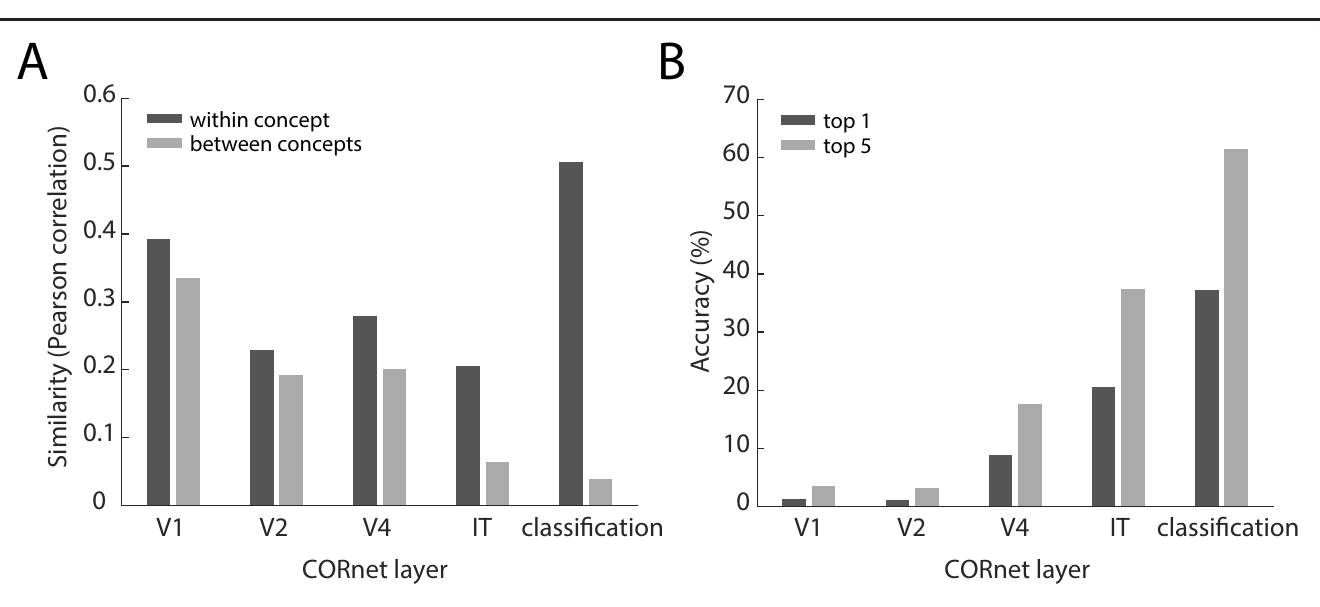
Fig 4. Selectivity of object images for different concepts. (A) Similarity of image activation vectors across different layers of the deep convolutional neural network CORnet [39]. The first four layers of CORnet are named after brain regions in the macaque monkey. Similarity was estimated by the mean Pearson correlation of activation patterns in a given layer. “Within concept” refers to the similarity of all pairs of activation vectors of images of the same concept, while similarity “between concept” refers to the similarity of those images and all other images in the database. Higher selectivity is indicated by a larger difference in “within concept” and “between concept” similarities. (B) Predictive accuracy of activation vectors based on their pairwise Pearson similarity. “Top-1 accuracy” refers to the percentage of the most similar images that belong to the same concept as a reference image and is averaged across all accuracies for all images. “Top-5 accuracy” allows five guesses. Note that this procedure is not directly comparable to that used in typical machine learning applications (see main text for